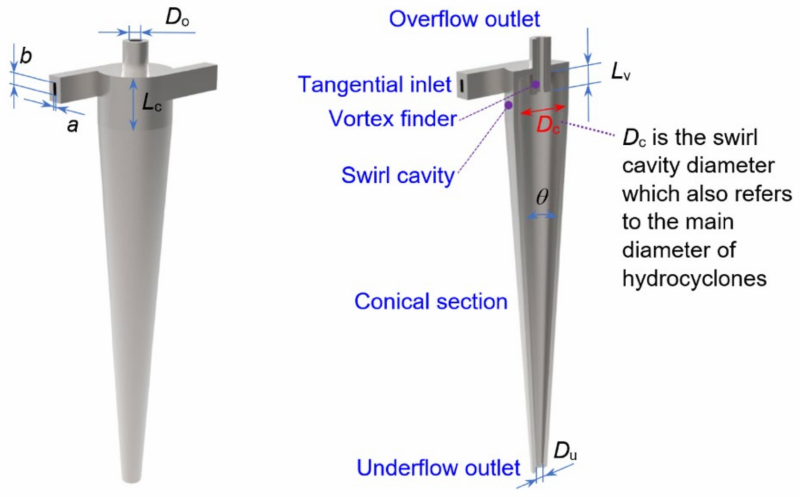
Figure 1. Schematic diagram of a typical